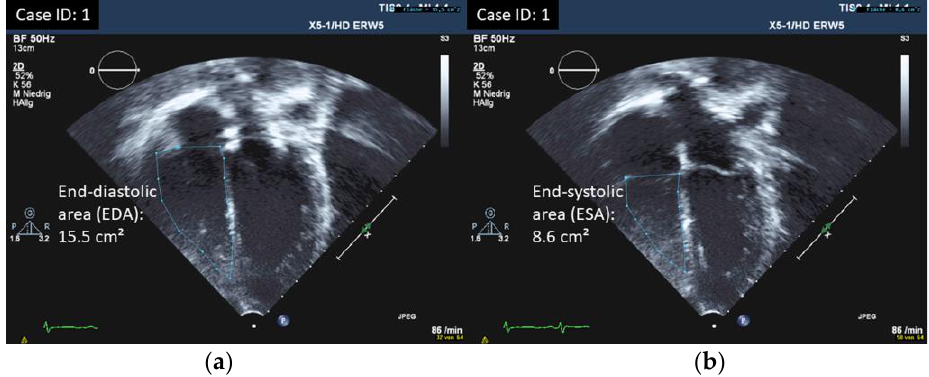
Figure 2. Measurement of RV-FAC ( a ) RV-EDA ( b ) ESA; FAC = 100% × (EDA − ESA)/EDA.